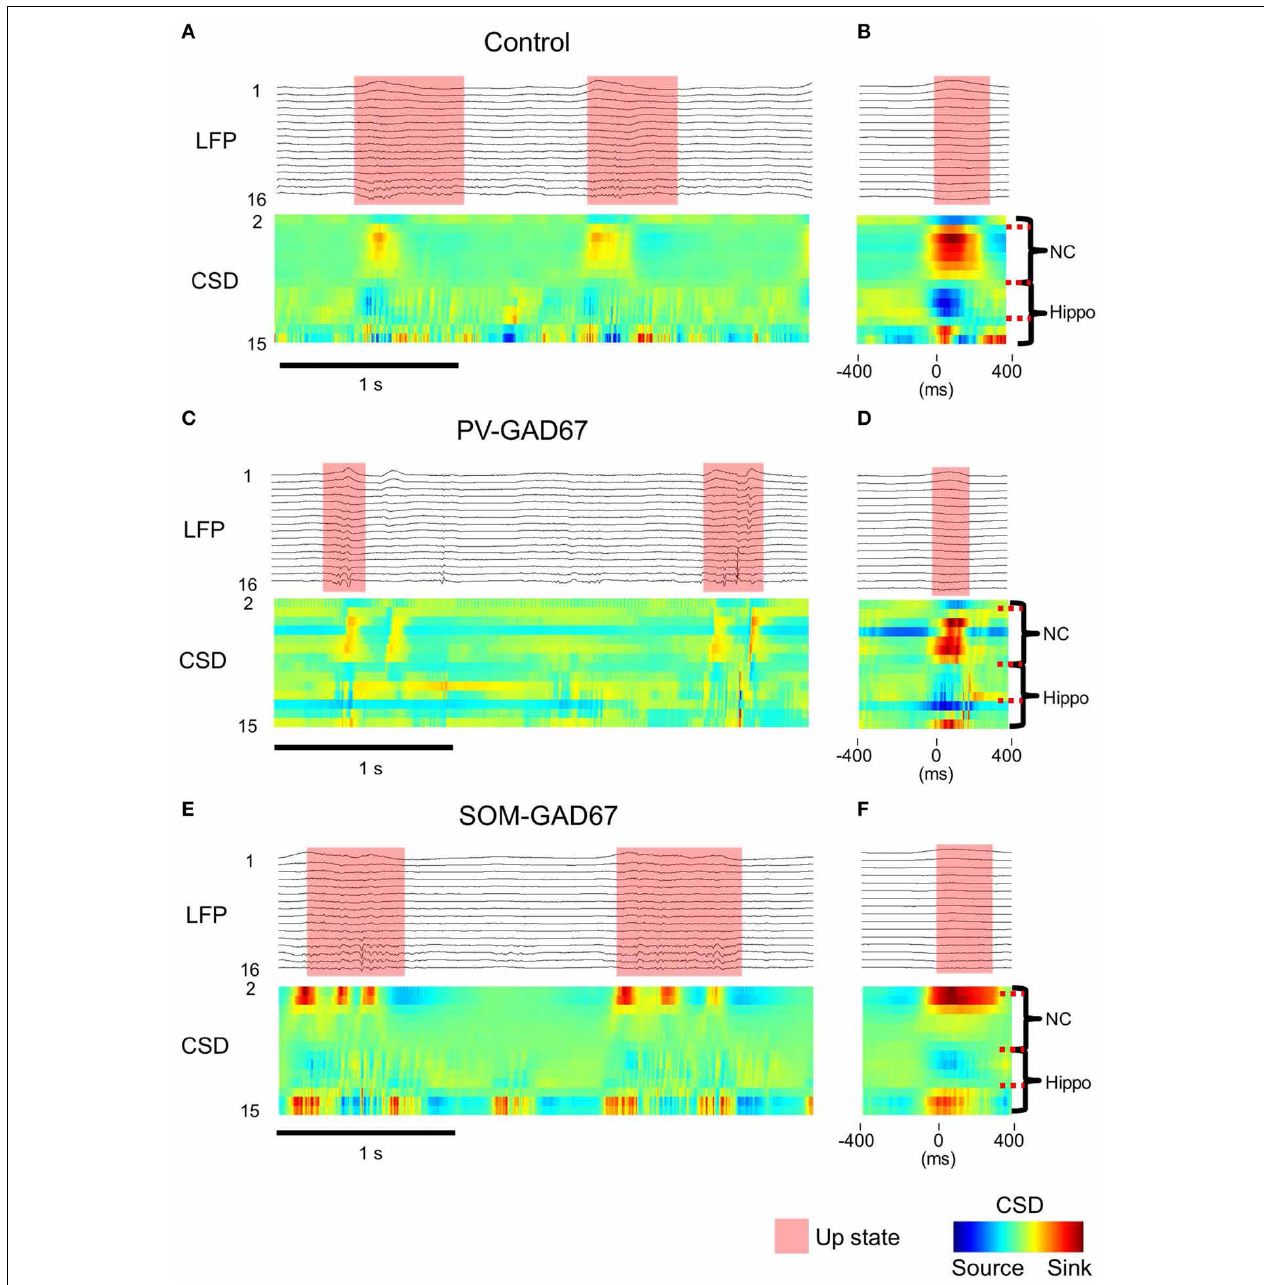
FIGURE 4 | CSD depth and temporal profile in the up state. (A) LFPs example from all channels (upper) and the CSDs example calculated from the LFPs in control mice. (B) Up state start-triggered average example of LFPs (upper) and that of CSDs (lower) in control mice. The probe position according